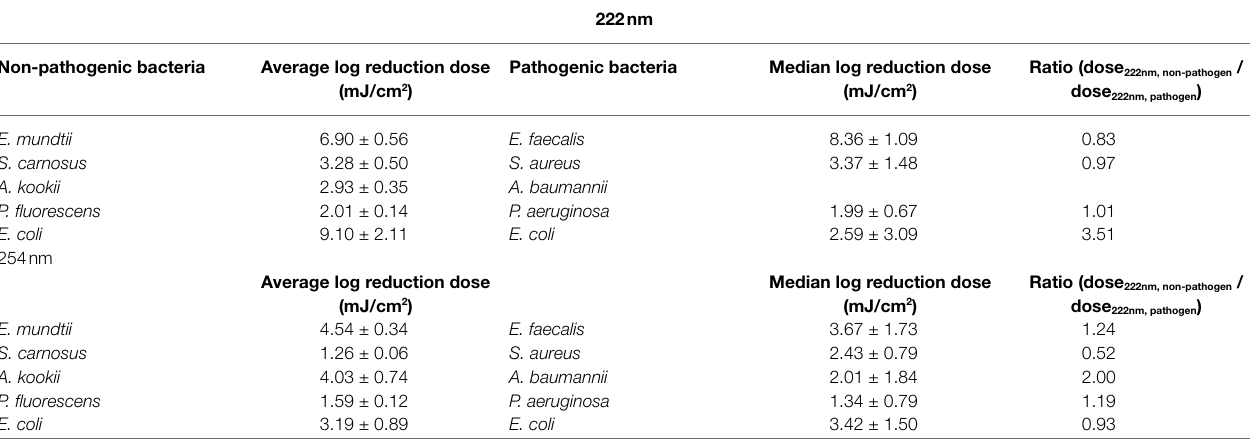
TABLE 3 | Comparative overview of (average) log reduction doses for ESKAPE pathogens and non-pathogen relative.